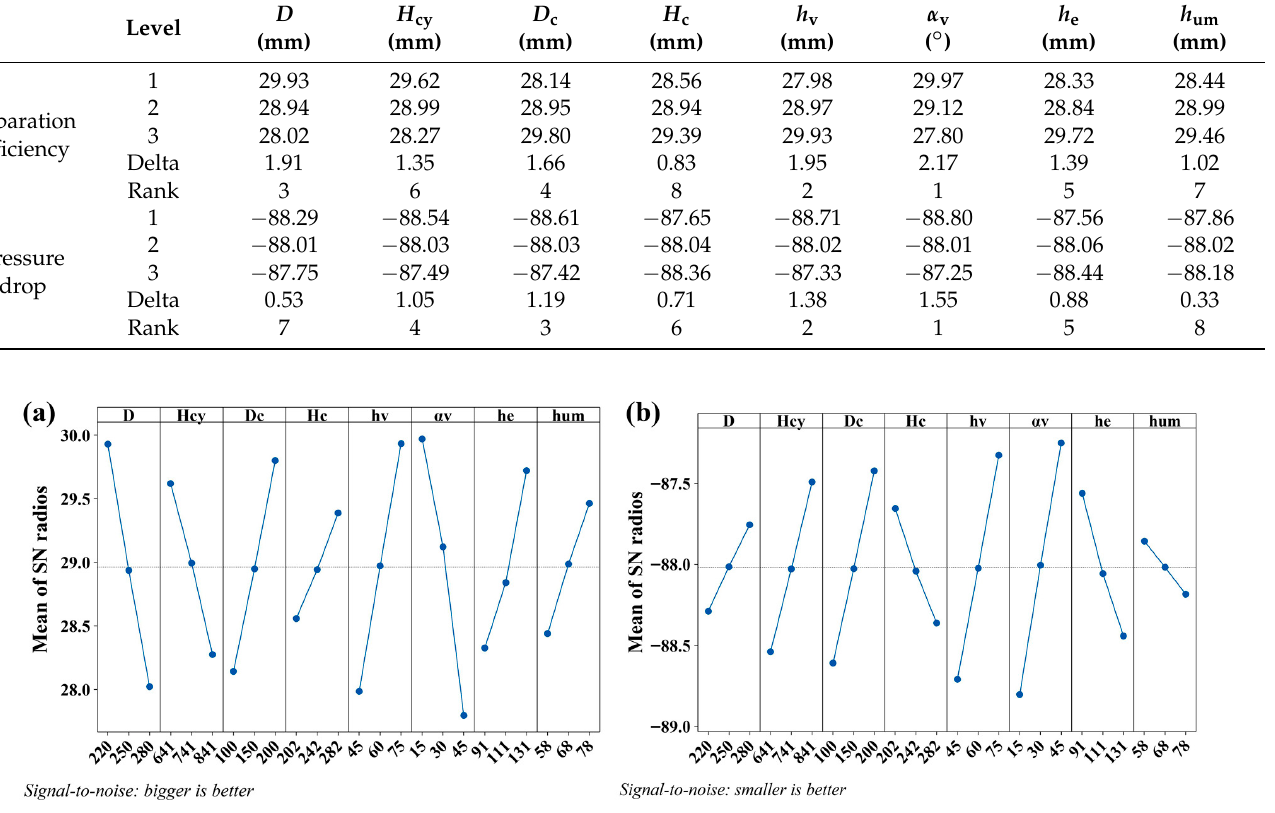
Figure 6. The mean of SNR vs the geometrical parameters of ( a ) separation efficiency and ( b ) pres- sure drop.